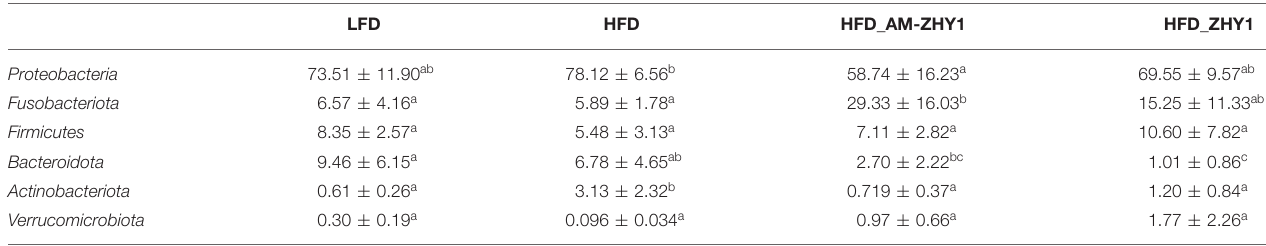
TABLE 4 | The relative abundance of each group of intestinal flora at the phylum level.